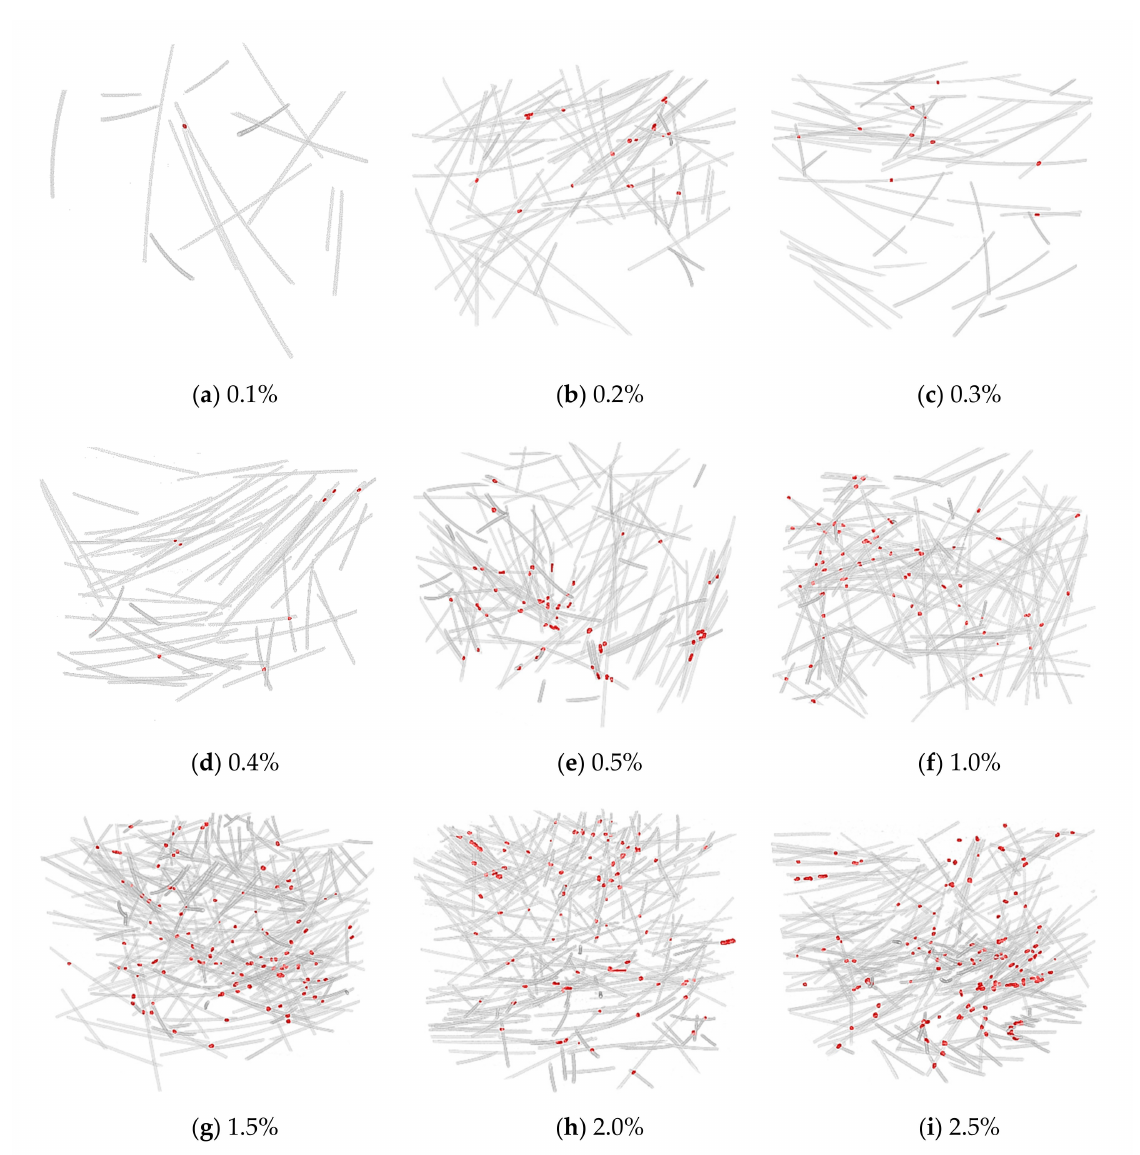
Figure 10. 3D visualization of separated fibers and contact points. Fibers and contact region colored as blue and red,